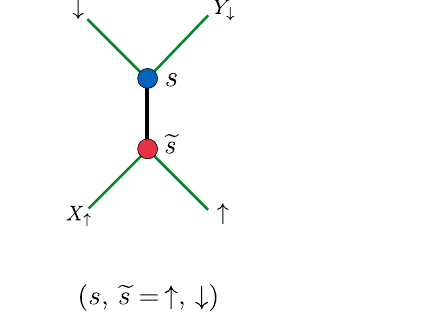
FIG. 13. Elementary tensor for the computation of boundary conditions in the top-left figure are for l